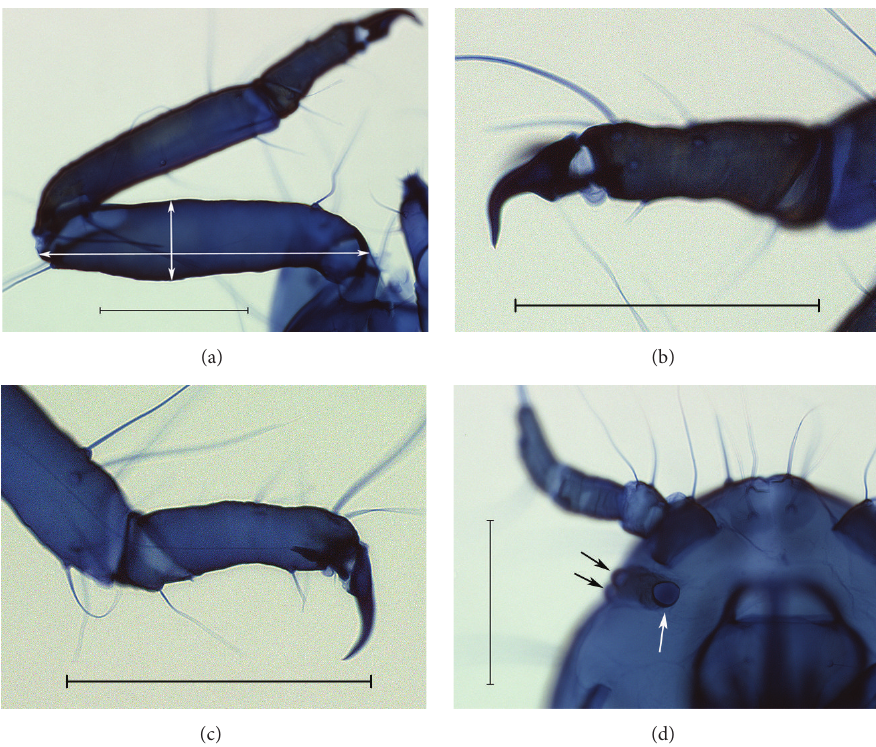
Figure 4: Forelegs and head of first-instar nymphs of the alate generation: (a) an entire foreleg of a typical defensive nymph, with double- headed white arrows indicating the length and width of a femorotrochanter defined in this paper; (b) fore tarsus of a typical defensive nymph with thick, strongly curved claws; (c) fore tarsus of a nymph produced early in autumn with slender claws; (d) head of a typical defensive nymph (ventral focus) indicating the downward-directed facet (by a white arrow) and the positions of the remaining two facets (by black arrows) of the left triommatidium. Scale bars: 100 𝜇